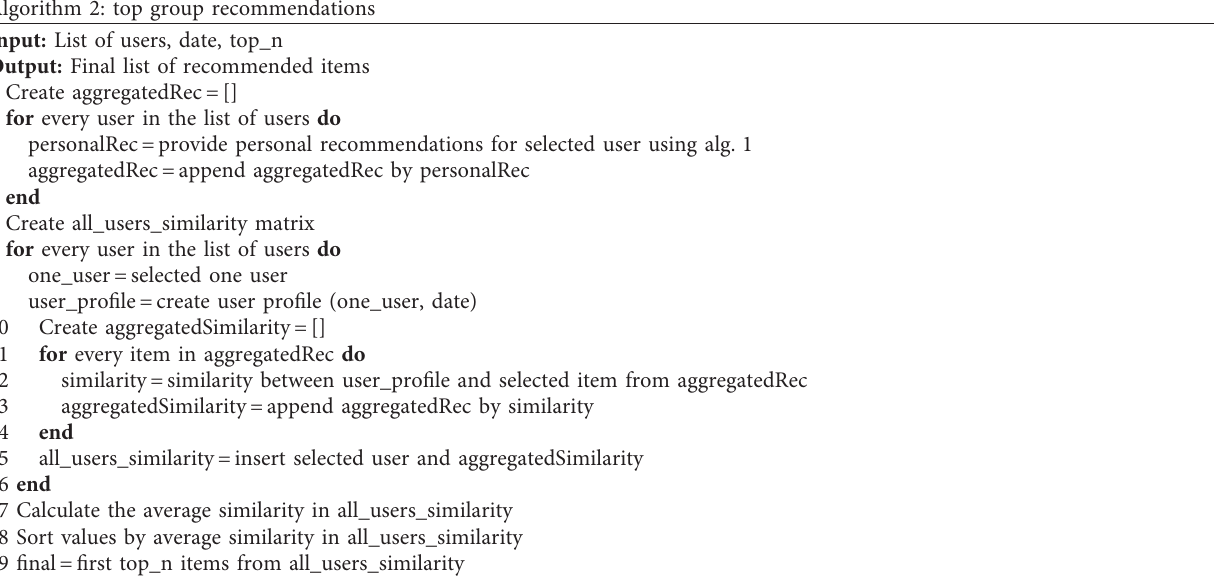
Table 2: The process to generate top group recommendations. Algorithm 2: top group